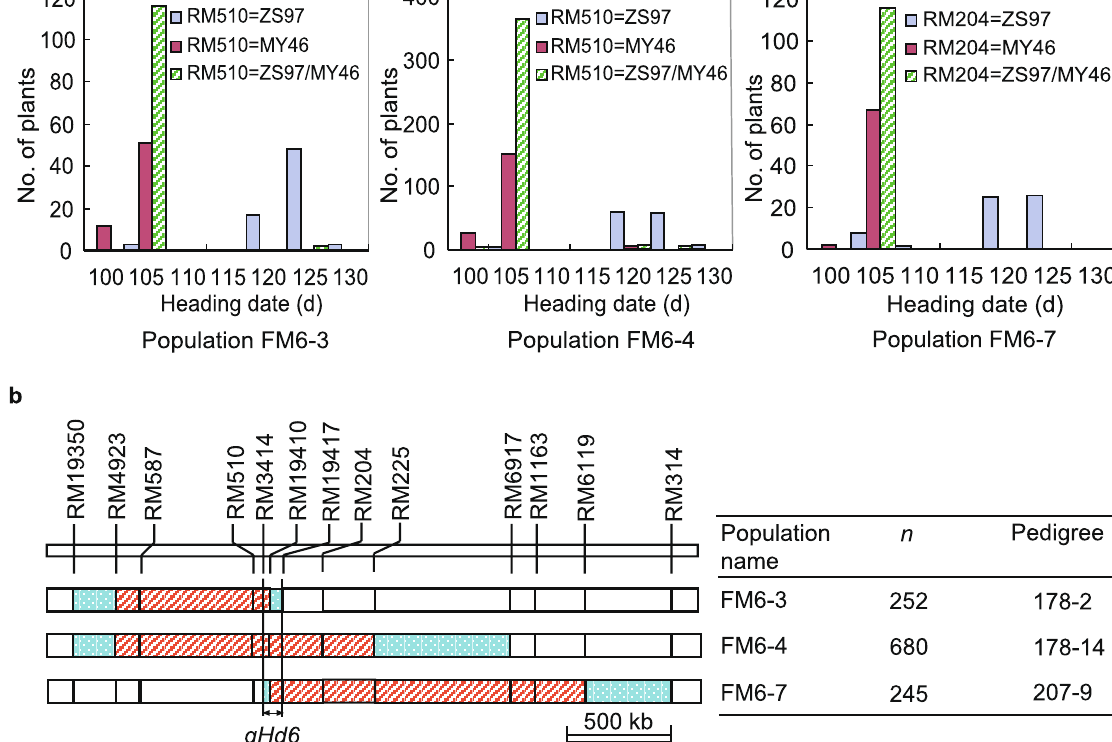
Population Name Trial site